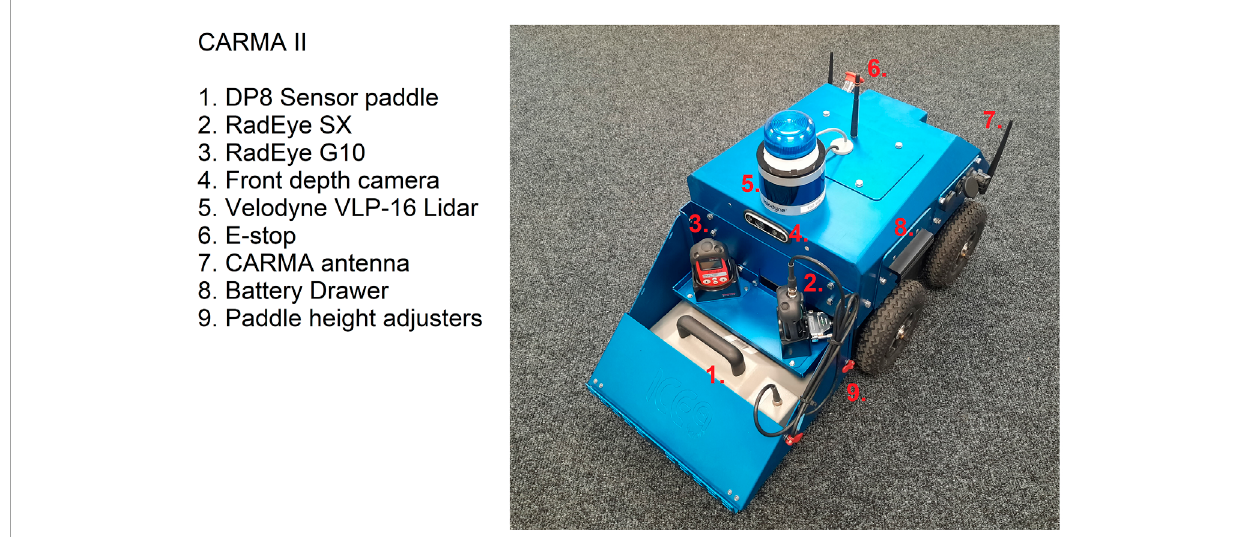
FIGURE 1 The hardware that has been developed for the CARMA II platform at the University of Manchester.